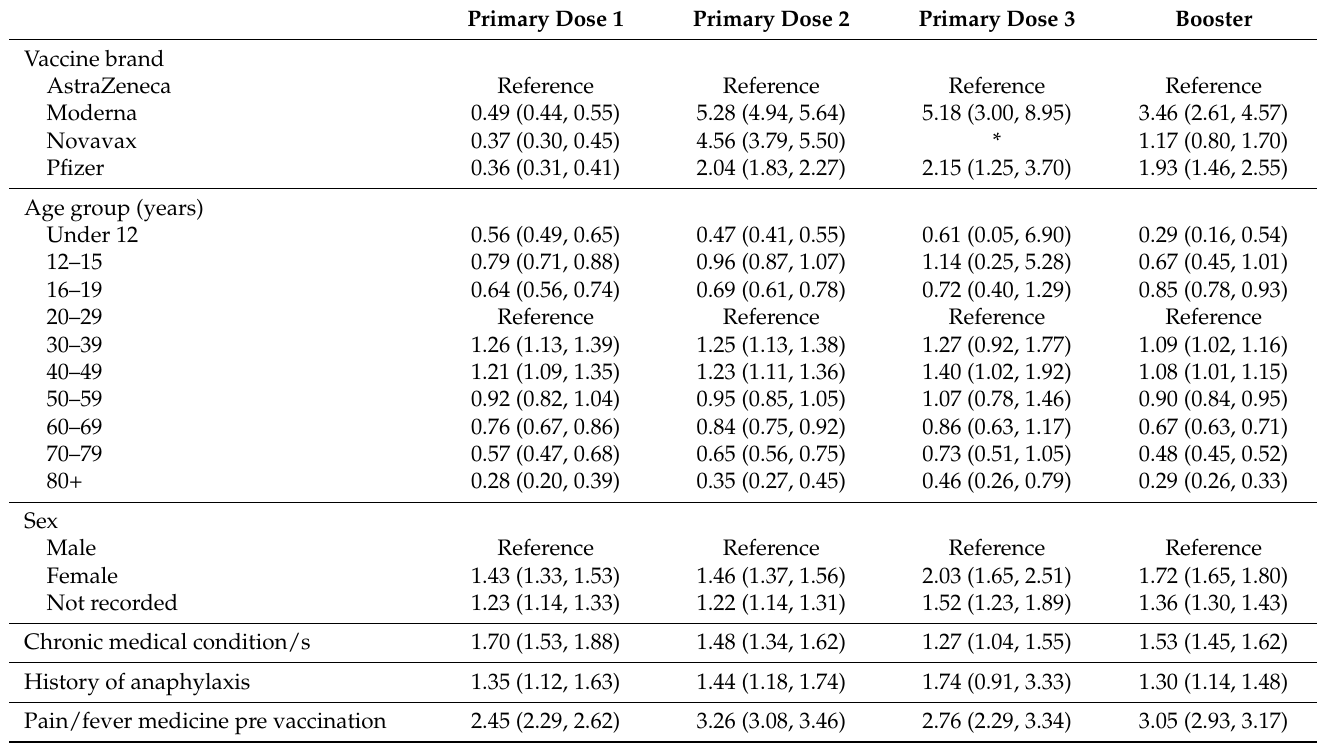
Table 2. Characteristics associated with the reporting of any event on day 3 following COVID-19 vaccinations at pharmacies. Values presented are adjusted odds ratios (95%